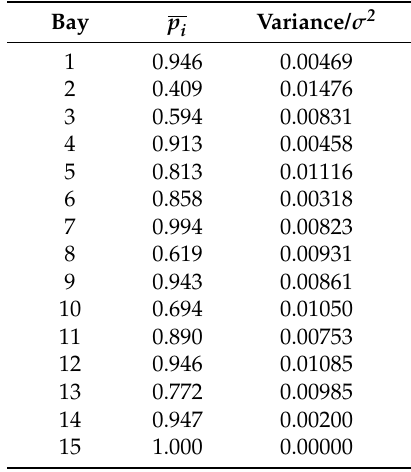
Table 1. Humidity characteristic coefficient of each